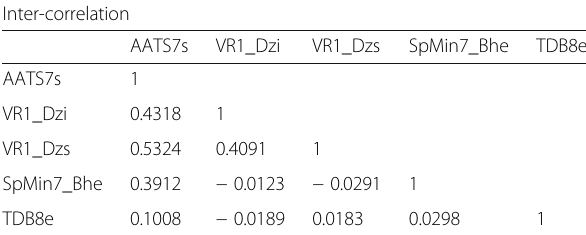
Table 4 Coefficient of Pearson ’ s correlation for descriptor in model